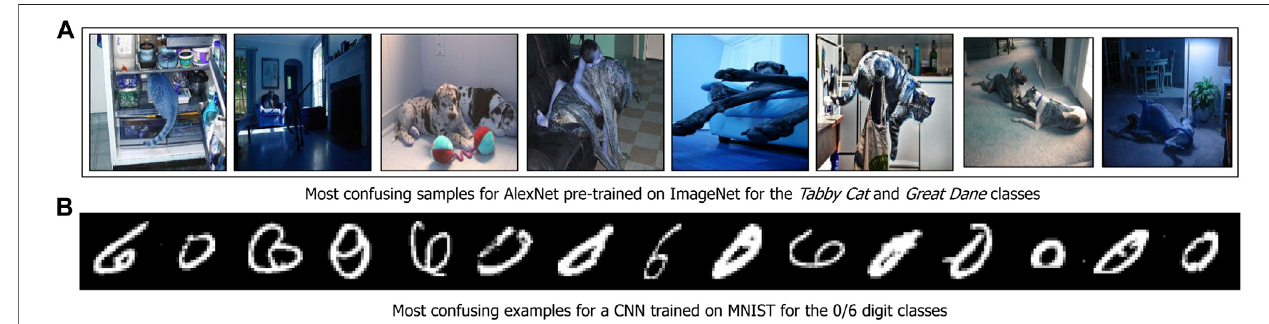
FIGURE 6 | Using MARGIN to sample near decision